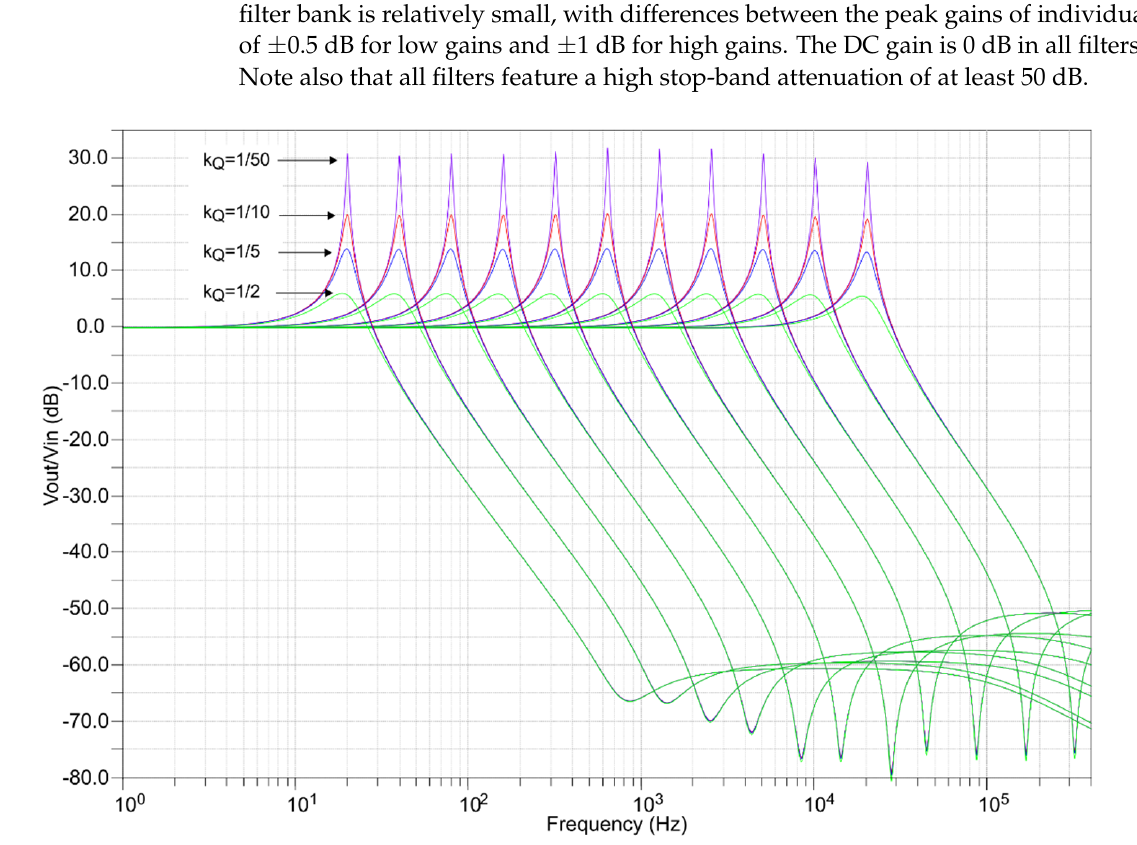
Table 1. Simulated 1 post ‐ layout parameters of the individual filters with V DD = 0.5 V.